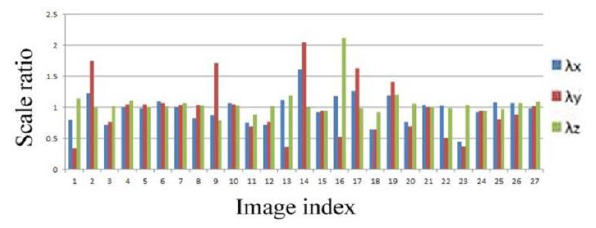
Figure 7. Scale ratios between the 3D reconstructed ground truth layouts and the created layouts for 27 images.